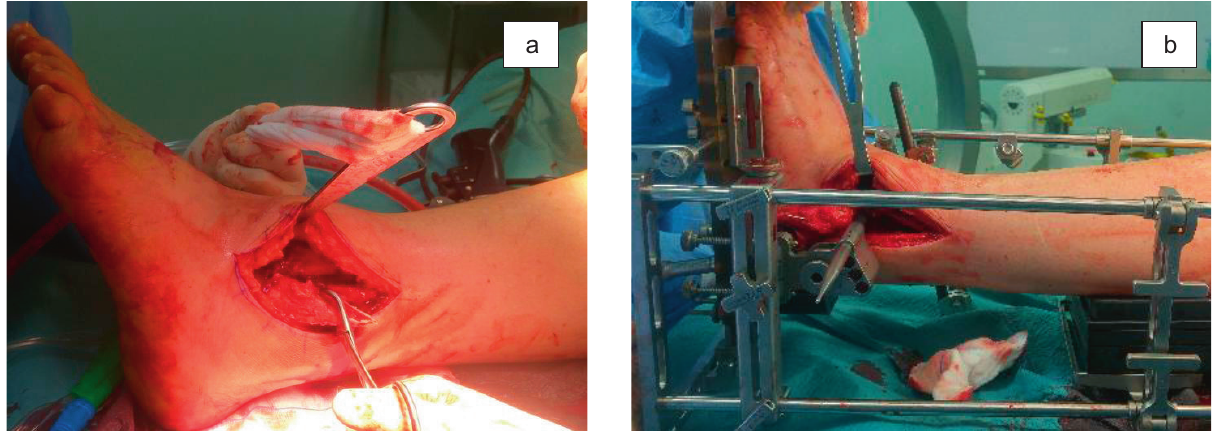
Figure 1. (a) The oblique fibular osteotomy and the reflection of the distal fibular fragment. (b) The correct internal rotation of the foot inside the alignment stand is checked. The lateral facet of the talus had to be parallel to the back end of the